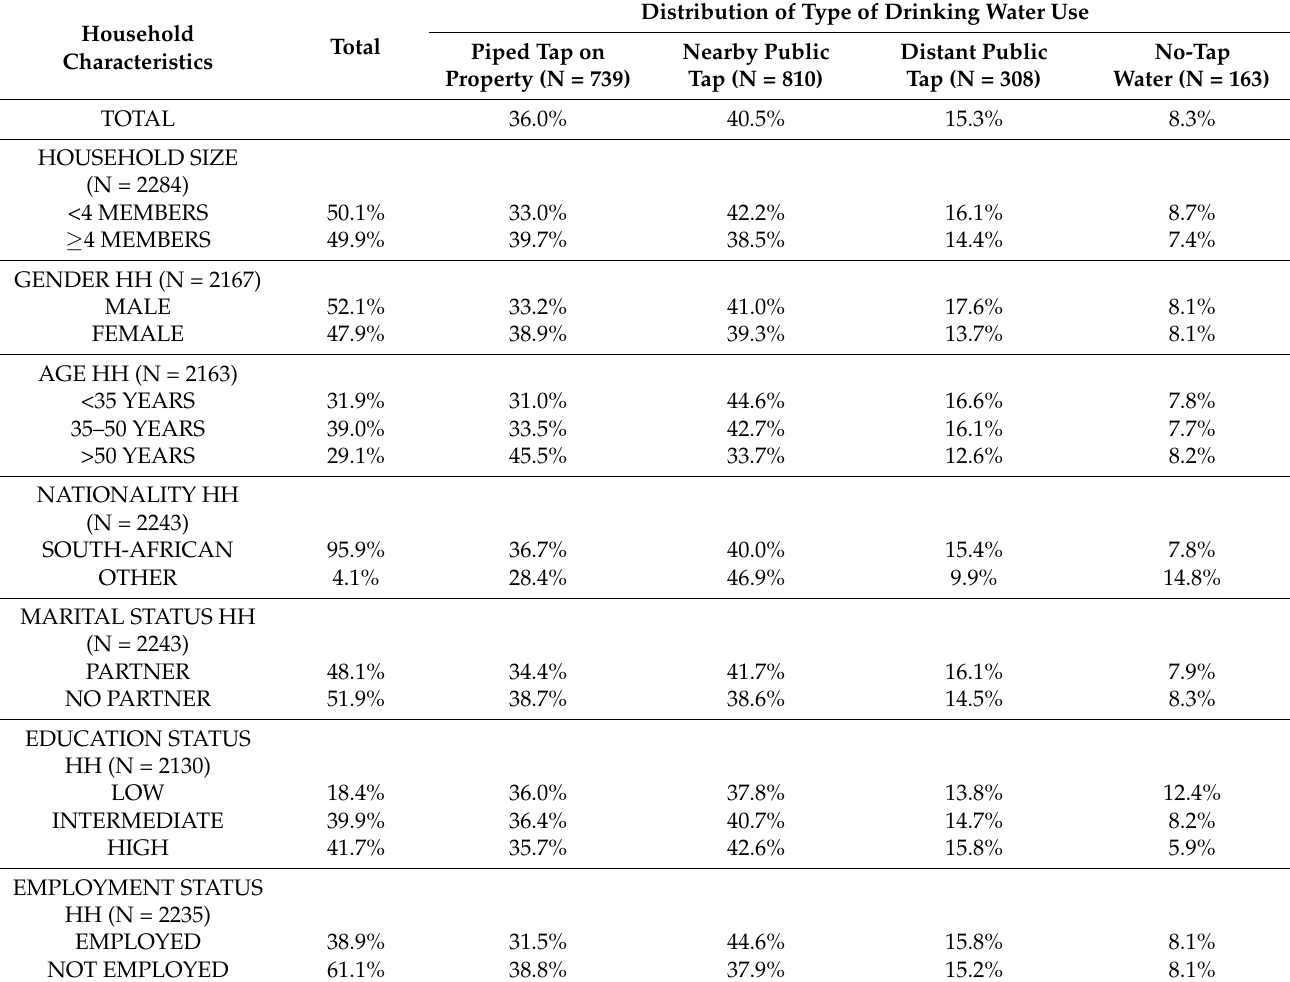
Table 1. Household characteristics and the distribution of type of drinking water use over the total group and over different population